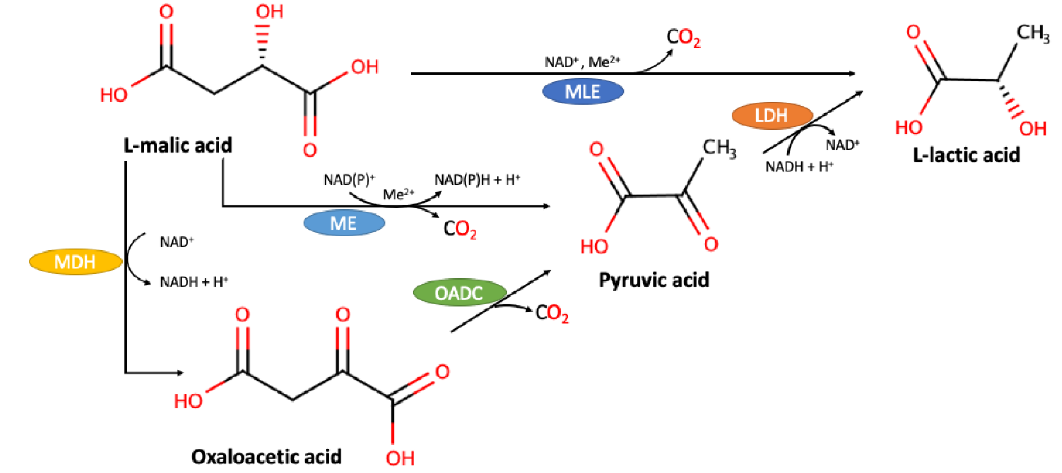
Figure 1. Possible biochemical routes responsible for the decarboxylation of L -malic acid to L -lactic acid. Image reproduced from Acevedo et al. [29]. MDH, malate dehydrogenase; ME, malic enzyme; MLE, malolactic enzyme; OADC, oxaloacetate decarboxylase; LDH, lactate dehydrogenase.